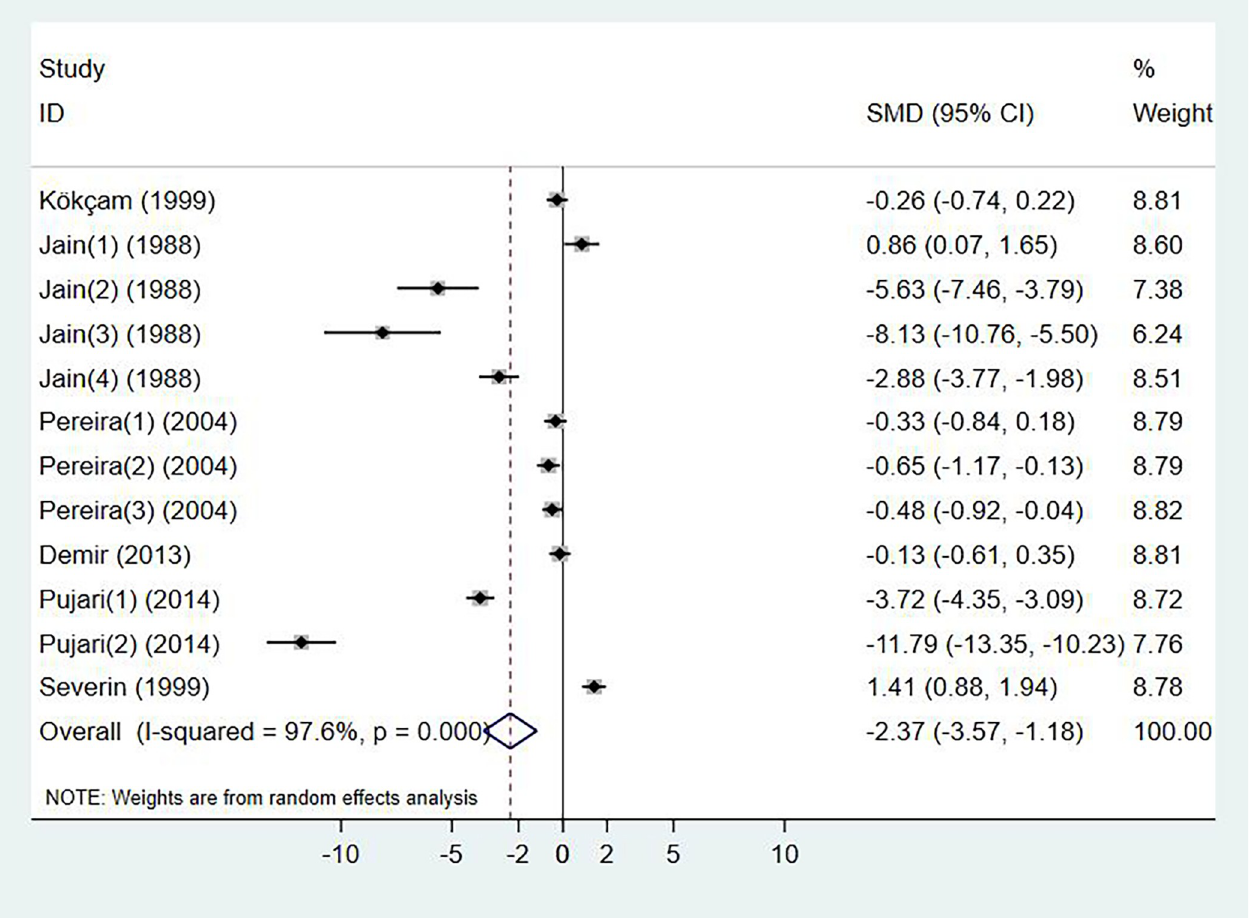
Fig 3. Forest plot in the meta-analysis of vitamin E levels and